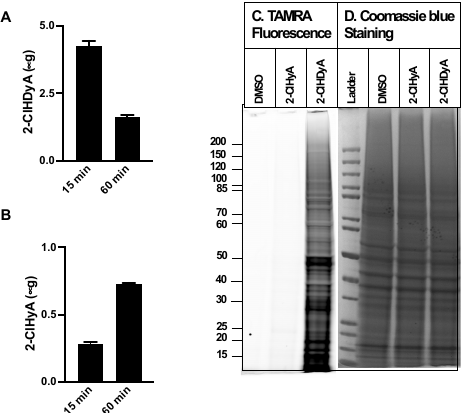
Figure 3. 2-ClHDyA metabolism and protein modification in EA.hy926 endothelial cells. EA.hy926 cells were treated with 10 μ M 2-ClHDyA for indicated time intervals. At the end of each time point, cellular and media lipids were extracted together, and 2-ClHDyA ( A ) and 2-ClHyA ( B ) were quantitated as described in “Materials and Methods”. Values are average + SEM for n = 4 in both A and B; ( C ) EA.hy926 cells were treated with either DMSO, 10 μ M 2-ClHyA, or 10 μ M 2- ClHDyA for 1 h at 37 °C. Proteins modified by these ω -alkyne chlorolipids were clicked with TAMRA-azide and were visualized after gel electrophoresis; ( D ) Coomassie blue staining of gel protein loads used for TAMRA fluorescence analyses.